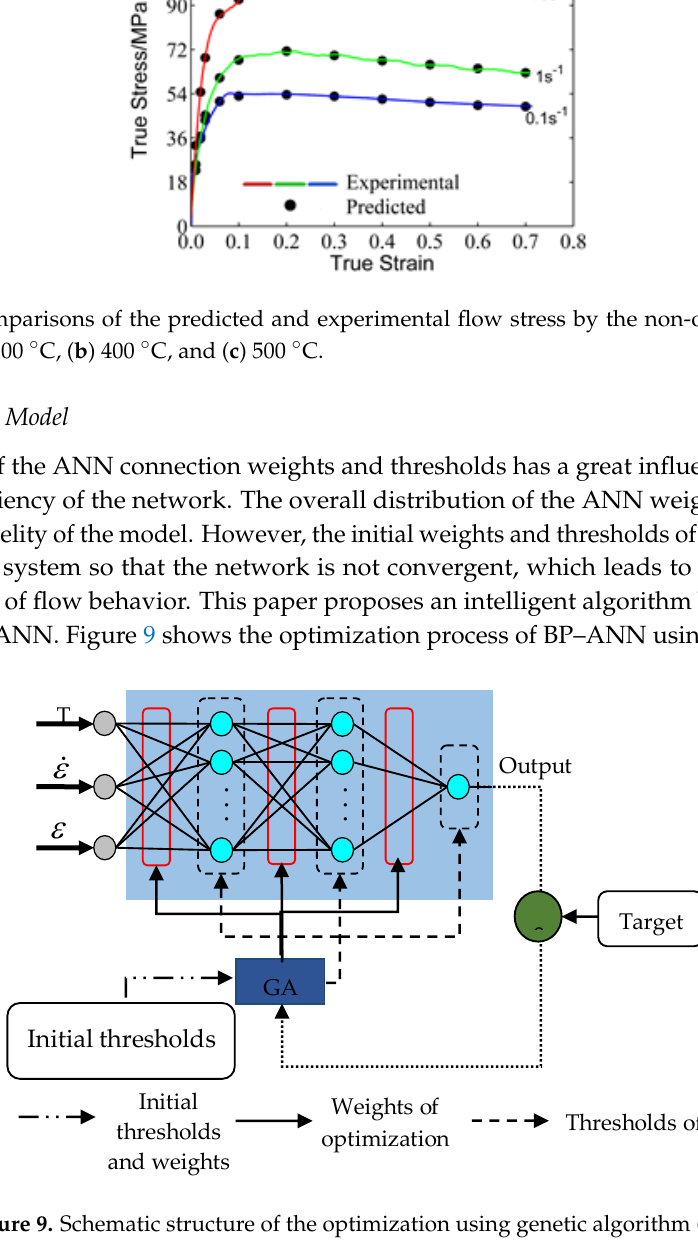
Figure 9. Schematic structure of the optimization using genetic algorithm (GA).